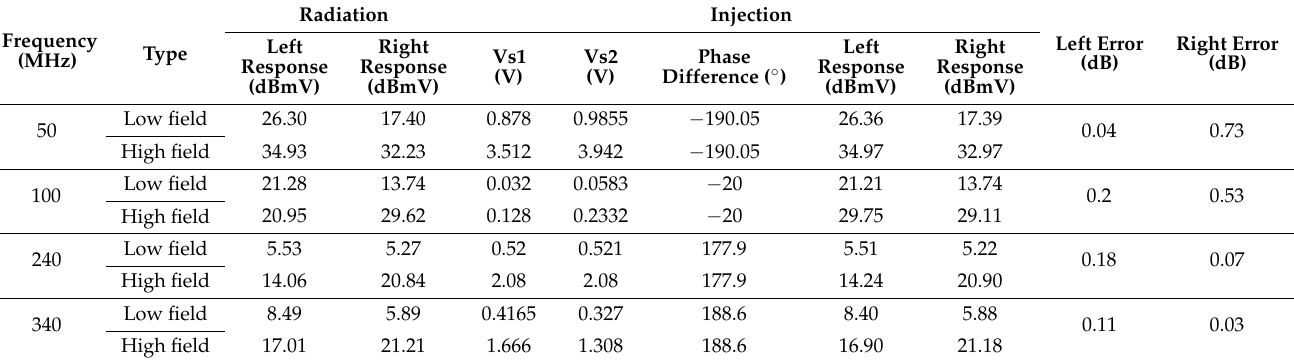
Table 1. Simulation results and